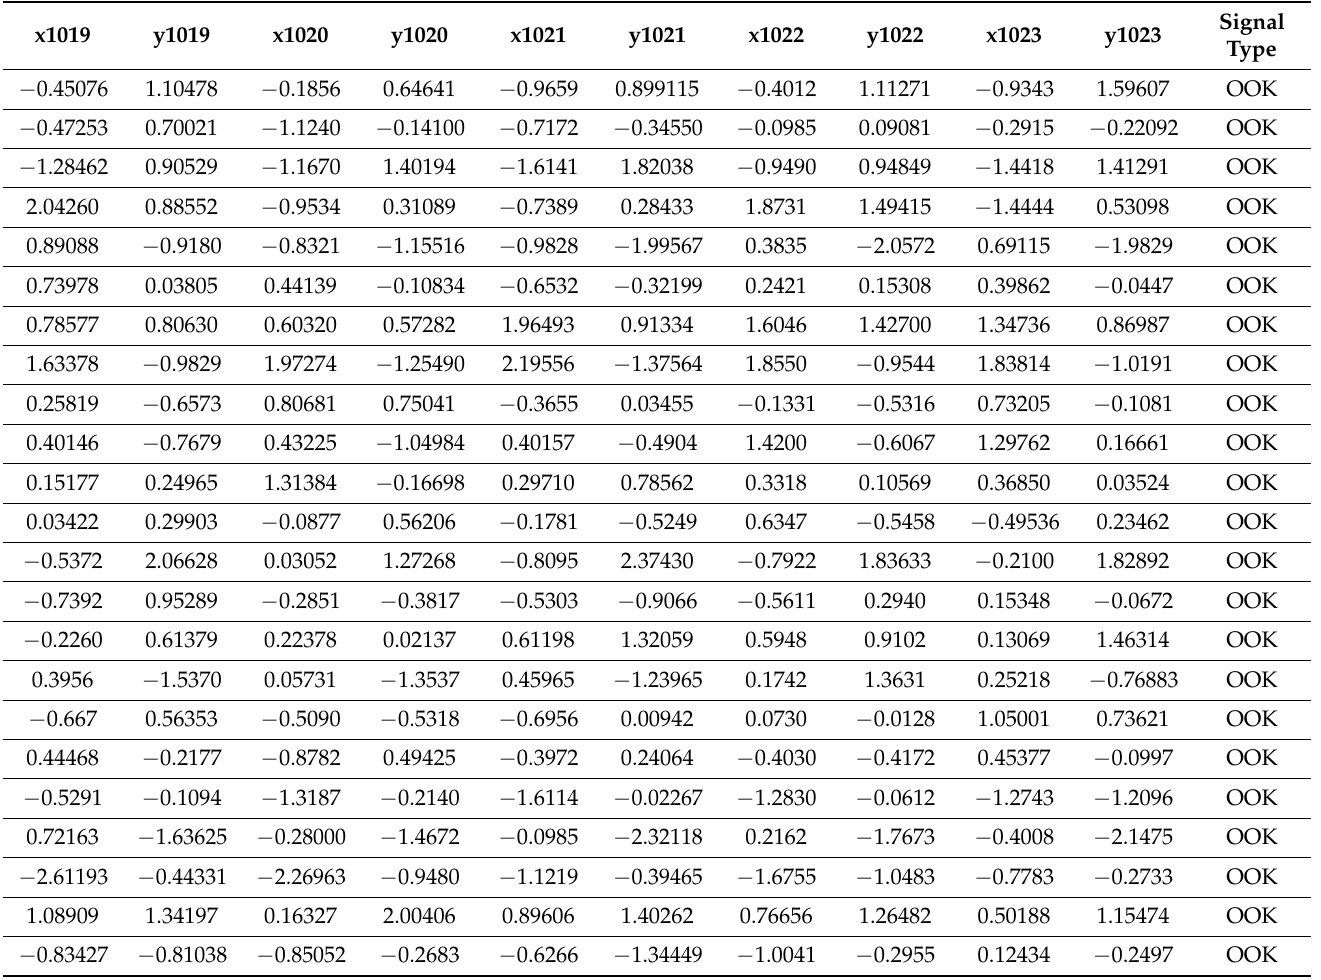
Table 2. Obtained